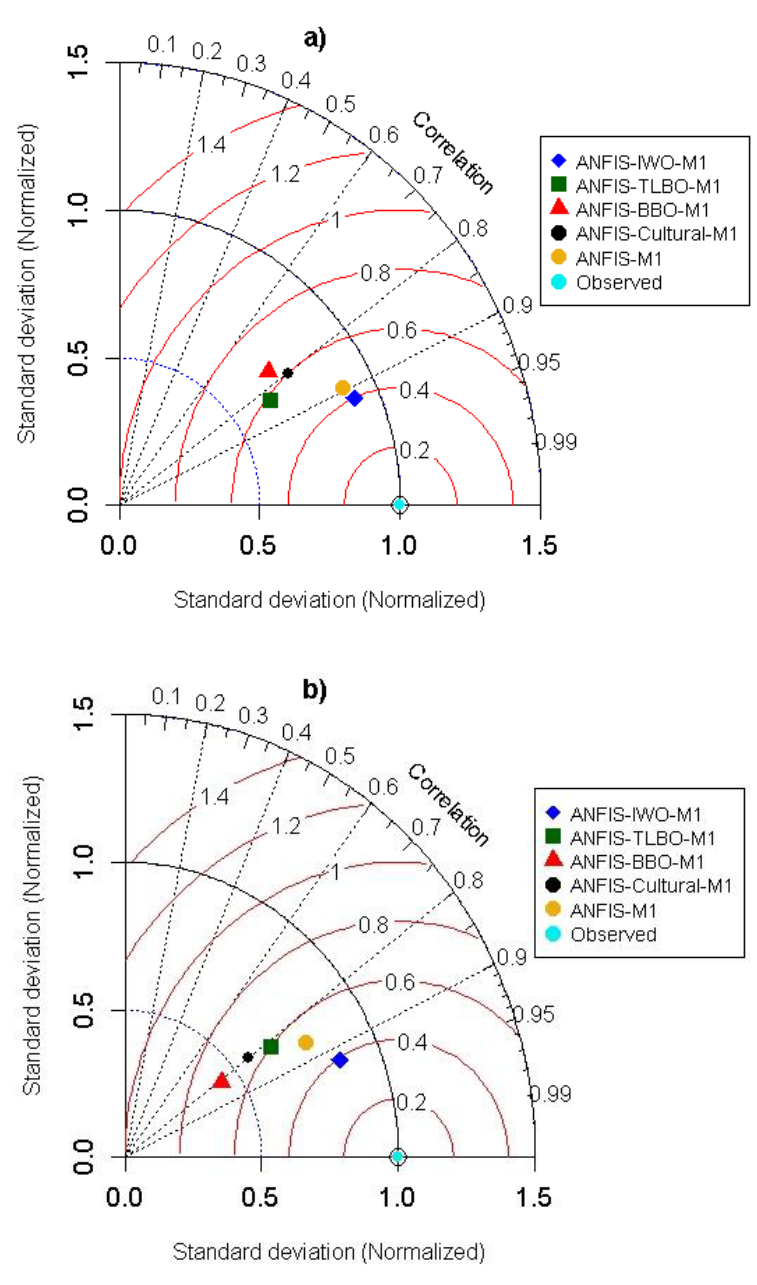
Figure 5. Normalized Taylor diagrams of predicted and observed scour depths values: ( a ) training phase, ( b ) testing phase. The iso-correlation, iso- RMSE , and iso-normalized standard deviation lines, respectively, are the black-dotted, red-solid, and black-solid contours.